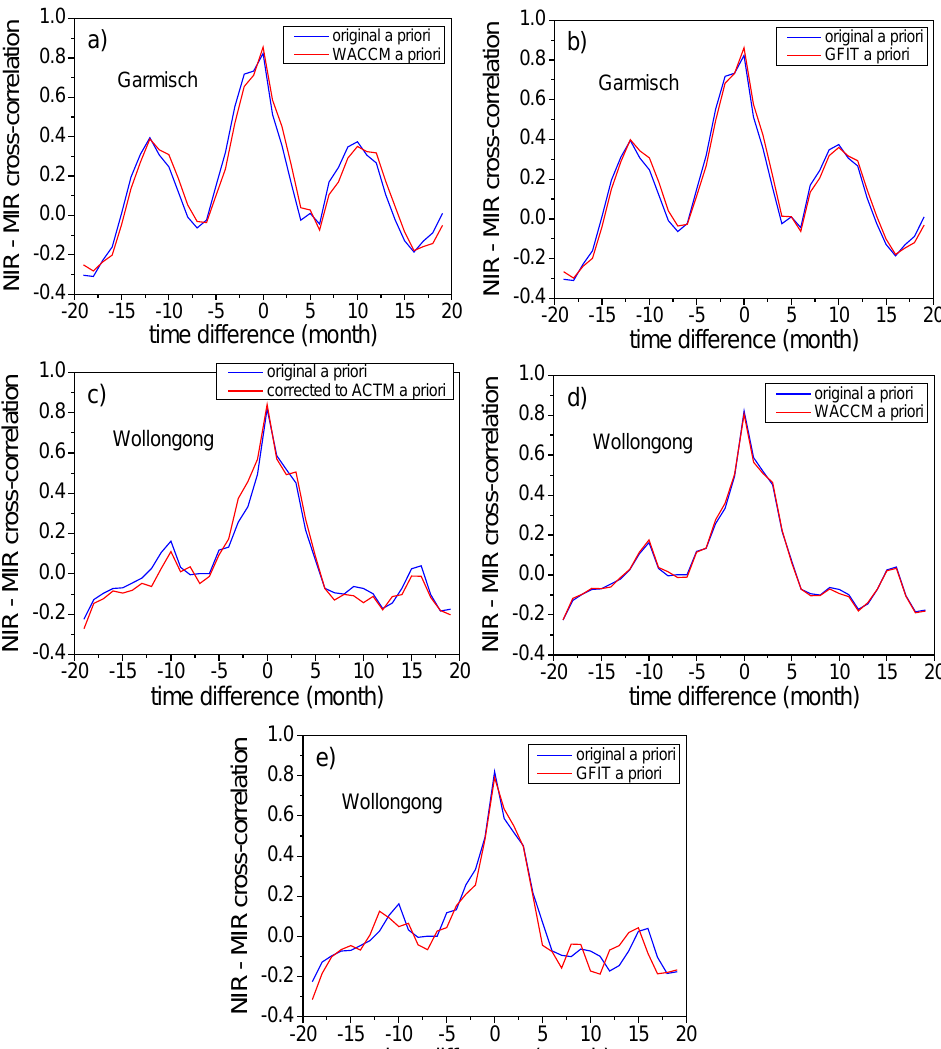
Fig. C3. Same as Fig. 6, i.e. cross-correlations using original priors (blue) compared to cases with varied common a priori profiles (red): (a) Garmisch with WACCM prior, (b) Garmisch with GFIT prior, (c) Wollongong with ACTM prior, (d) Wollongong with WACCM prior, and (e) Wollongong with GFIT prior.